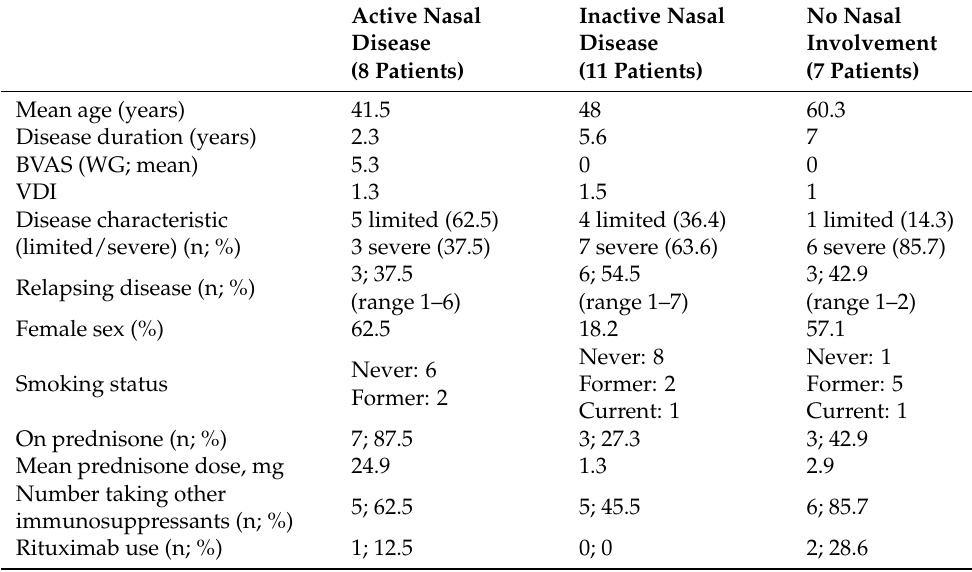
Table 1. Baseline characteristics and treatment of patients with proteinase 3 (PR3)-ANCA vasculitis, subdivided in those with active and inactive nasal disease activity, and those with no nasal